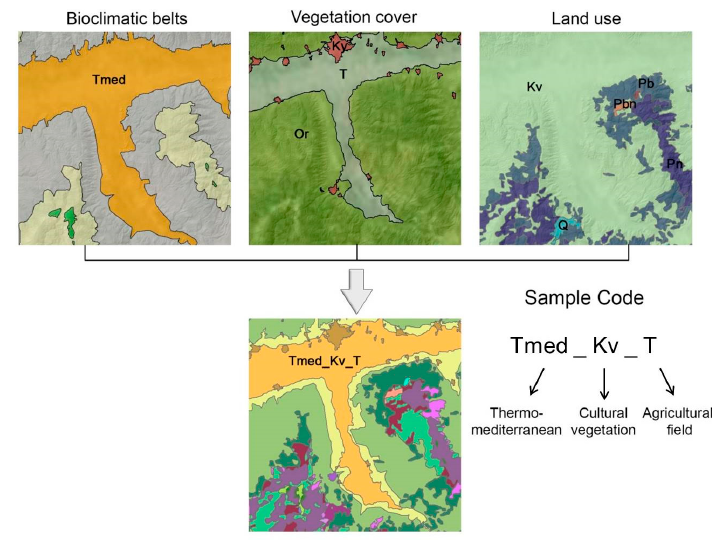
Figure 3. The configuration of the landscape codes and the case of a salt marsh/sand dune landscape.